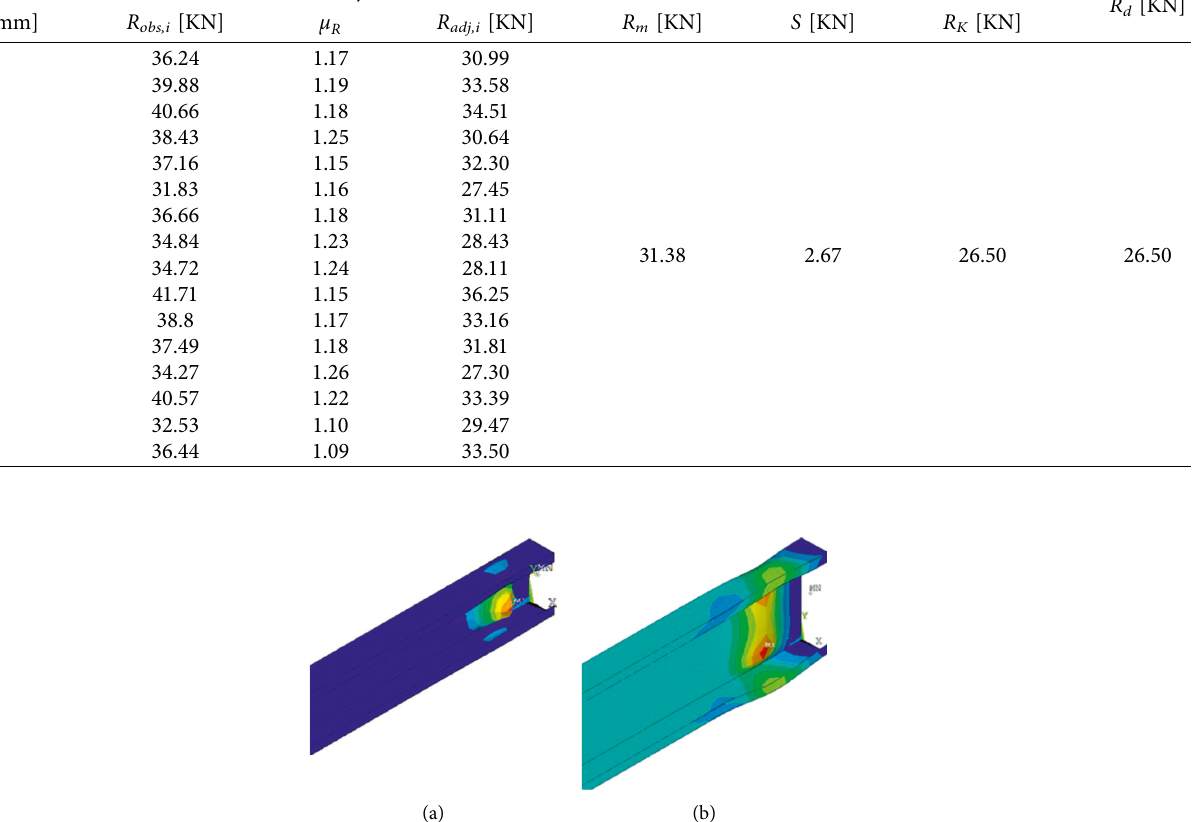
Table 8: Test-based design values of specimens with PAC mixtures “ A ” and “ X .” Measured values Adjusted resistances